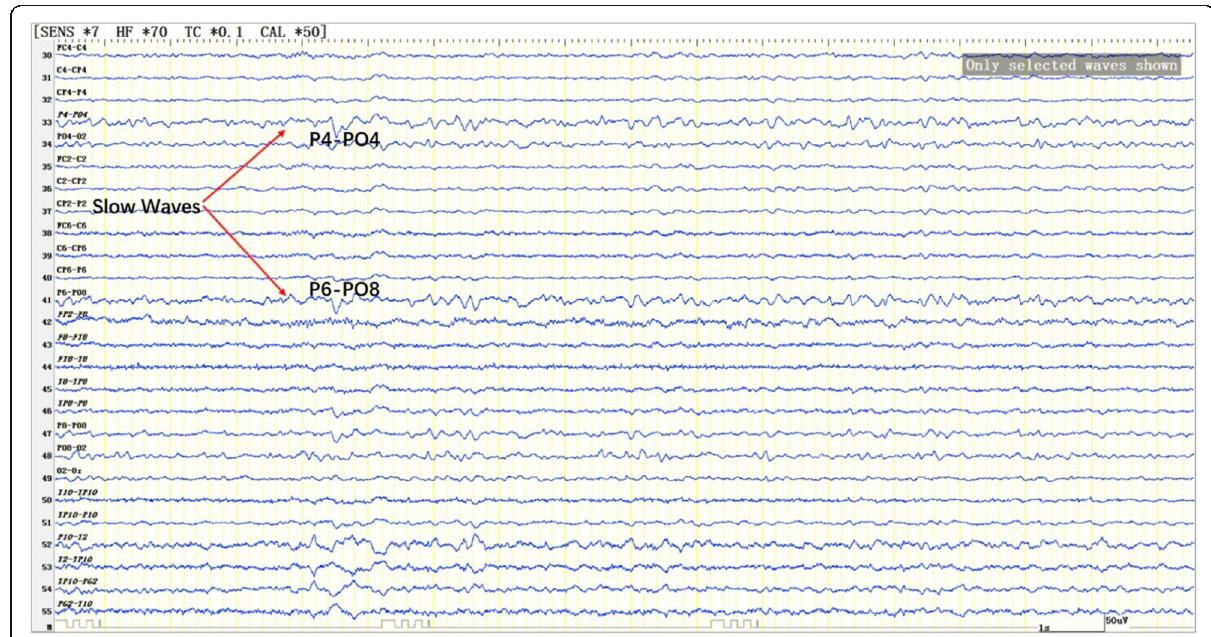
Fig. 3 The interictal EEG monitoring with high density international 10% system. The red arrows indicate slow waves on P4-PO4 and